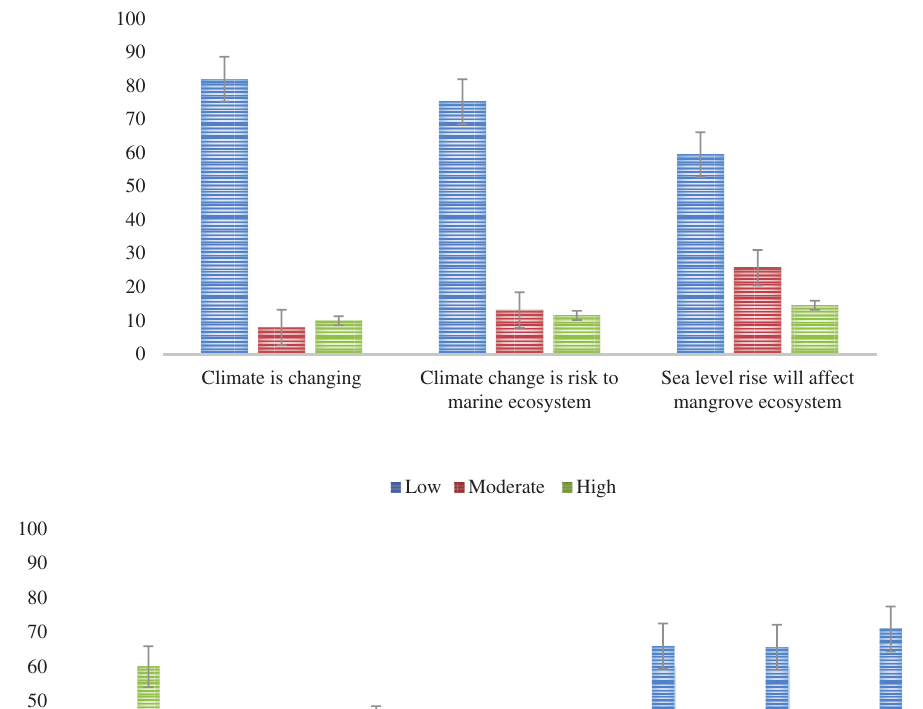
Proportion of participants who perceive low, moderate or high frequency of experience of various climate change impacts. The response options provided to the participants is a bipolar rating scale: 1 = very low to 7 = very high. Low category included scores 1–3, moderate category score 4, and high category scores 5–7 (n = 291). (Graph whiskers are standard error of the mean.) (Source: Authors,